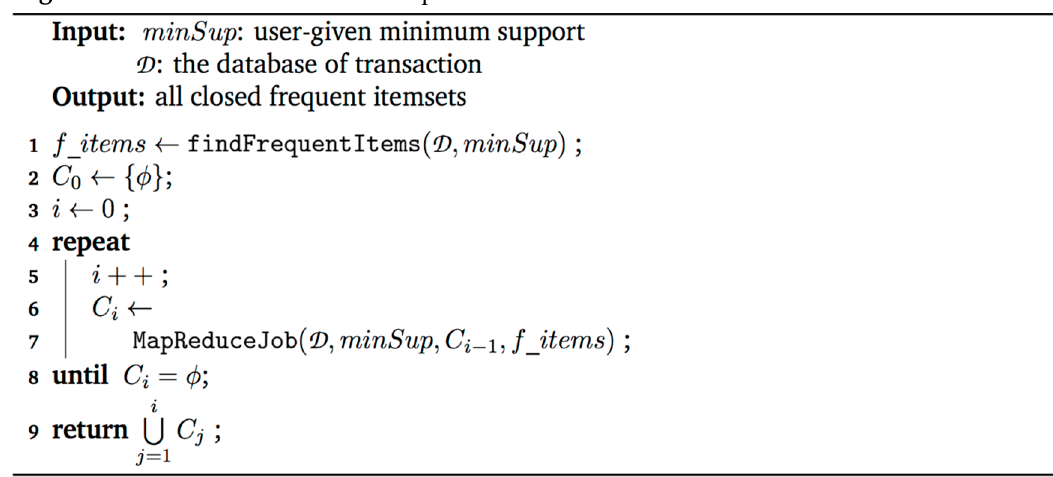
Algorithm 1. Main: Mine Closed Frequent